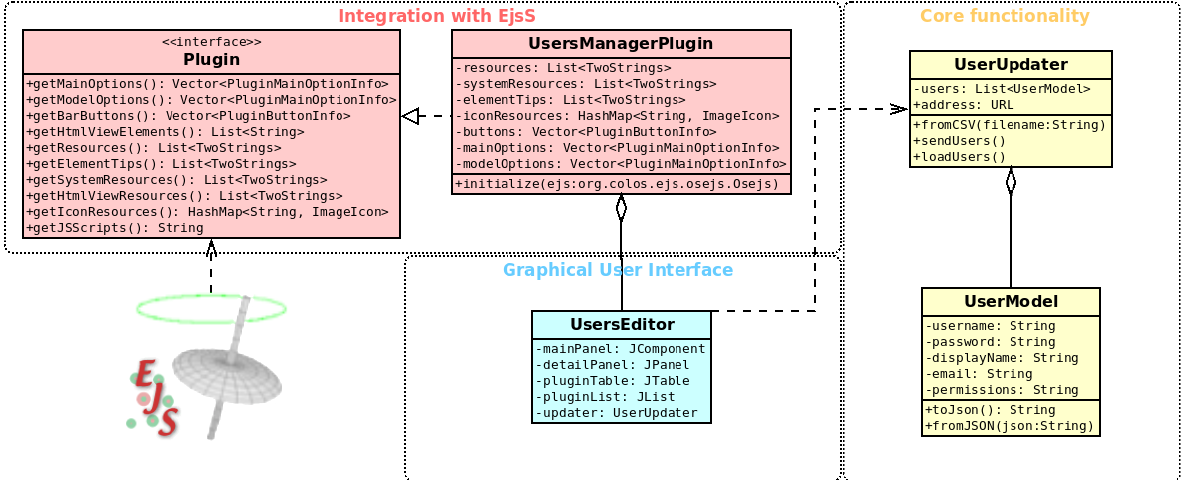
Figure 6. UML class diagram of the Users Manager.